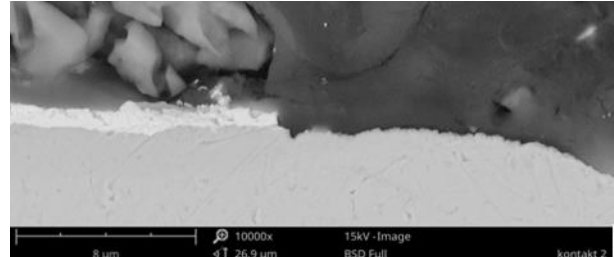
Fig. 3. Scanning microscope image of sample number 2 – the place of the beginning of coating application – visible layer break